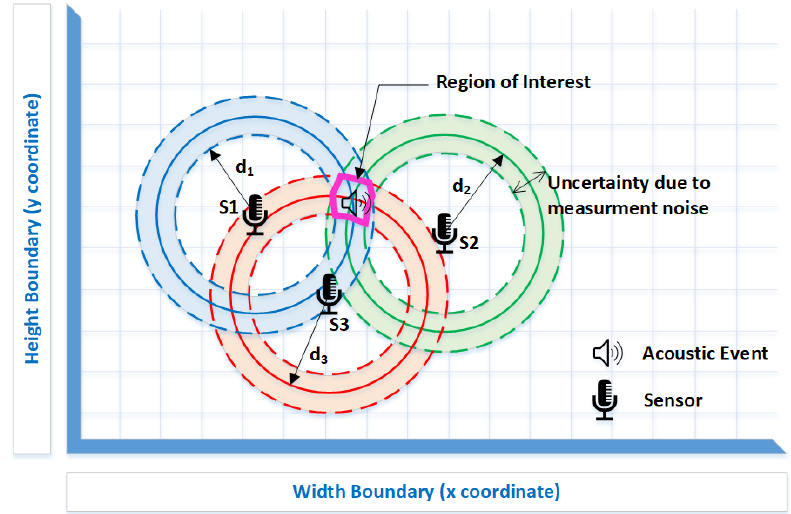
Figure 1. Geometry of the search space and measurement uncertainties.